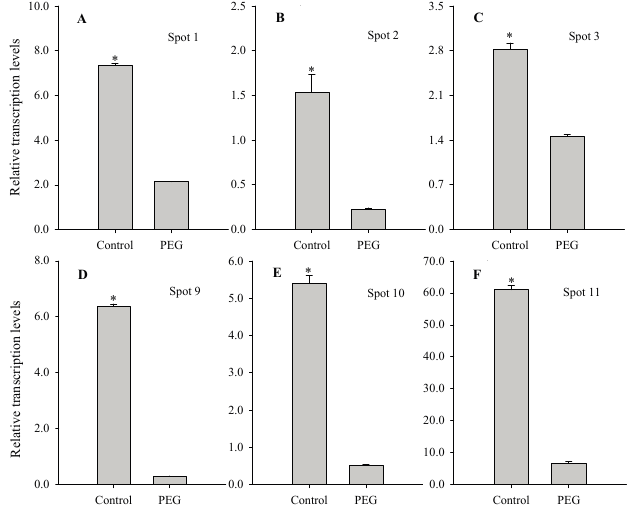
Figure 5. Transcription levels of the genes encoding six water deficiency-responsive protein species in leaves of maize seedlings exposed to PEG-stimulated water deficiency for two days. Asterisks indicate significant differences between control and PEG-stressed maize seedlings at p < 0.05. Bars represented standard errors of triplicate experiments. Fold change in mRNA level was determined using the 2 −ΔΔ C t method. Spot 1 ( A ); β - D -glucan exohydrolase; Spot 2 ( B ); 17.4 kDa class I heat shock; Spot 3 ( C ); 16.9 kDa class I heat shock protein 1; Spot 9 ( D ); electron carrier/electron transporter iron ion binding protein; Spot 10 ( E ); fumarylacetoacetate hydrolase domain-containing protein 1; Spot 11 ( F ), ribulose bisphosphate carboxylase/oxygenase